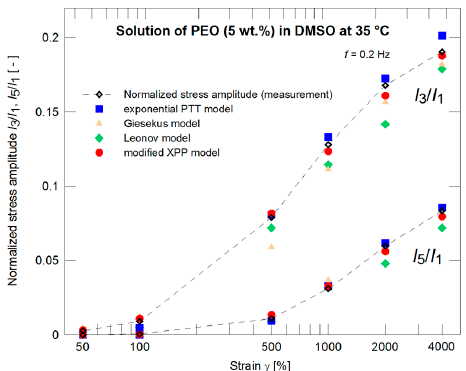
Figure 10. Optimization of the normalized stress amplitudes I 3 / I 1 and I 5 / I 1 by the exponential PTT, Giesekus, Leonov, and modified XPP models for strains of 50%, 100%, 500%, 1000%, 2000%, and 4000%.